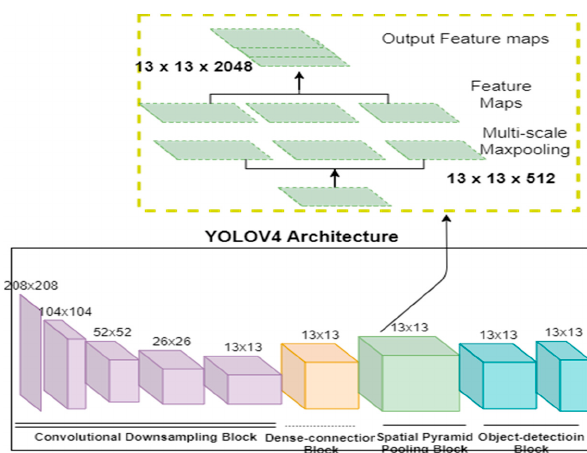
Sensors 2021 , 21 , x FOR PEER REVIEW Figure A1. YoloV4 architecture with different blocks [42]. Figure A1. YoloV4 architecture with different blocks [42].